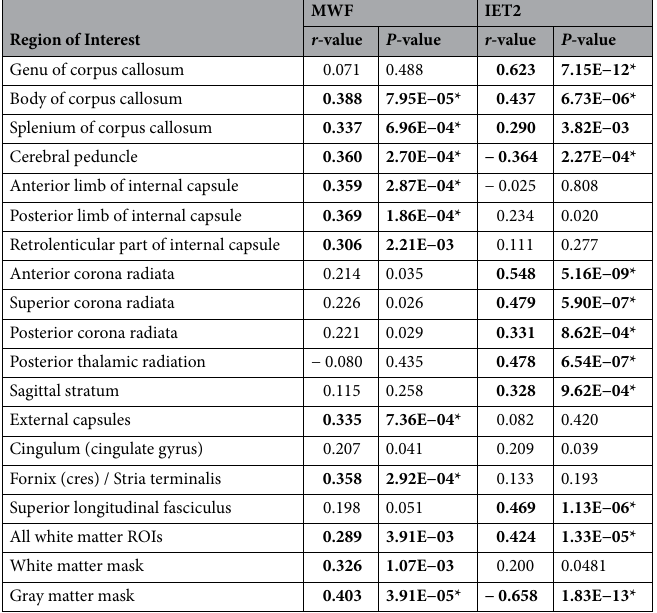
Table 1. Pearson correlation coefficients and P -values for correlation between age and mean myelin water fraction (MWF), and age and mean geometric mean T 2 of intra- and extra-cellular water (IET2), for each region of interest. Statistically significant correlations are bold for P < 0.01 and bold* for P <